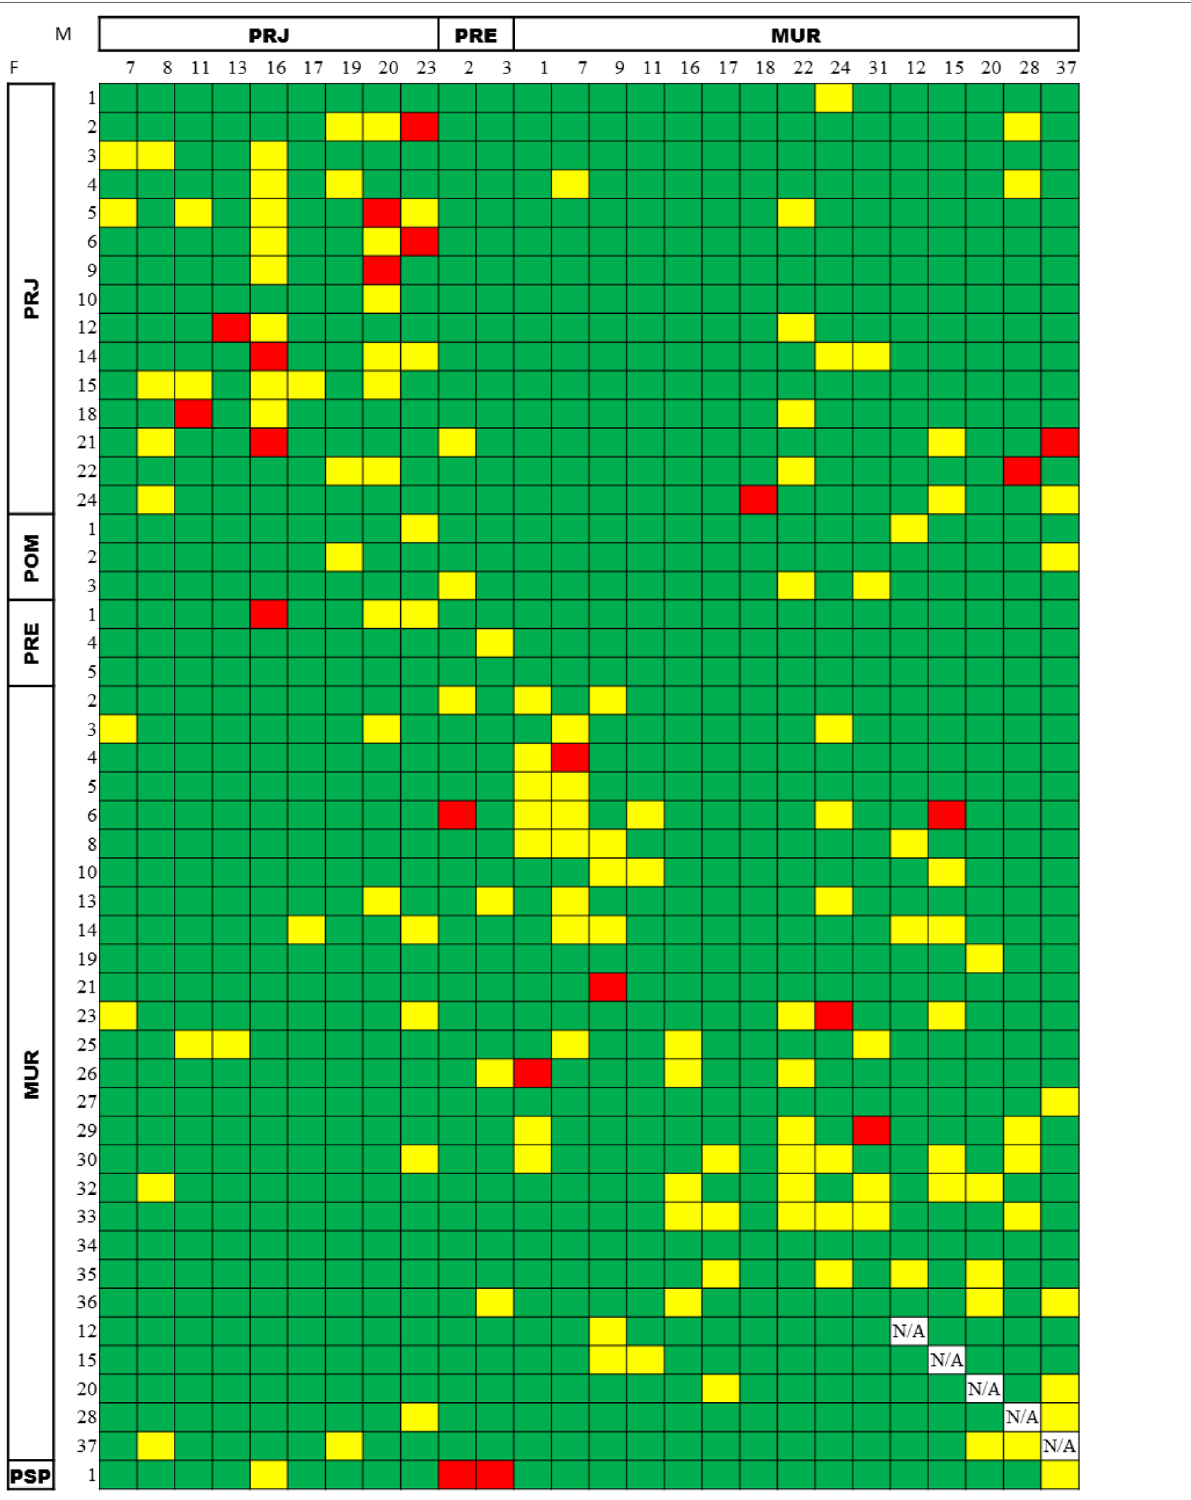
Frontiers in Genetics |